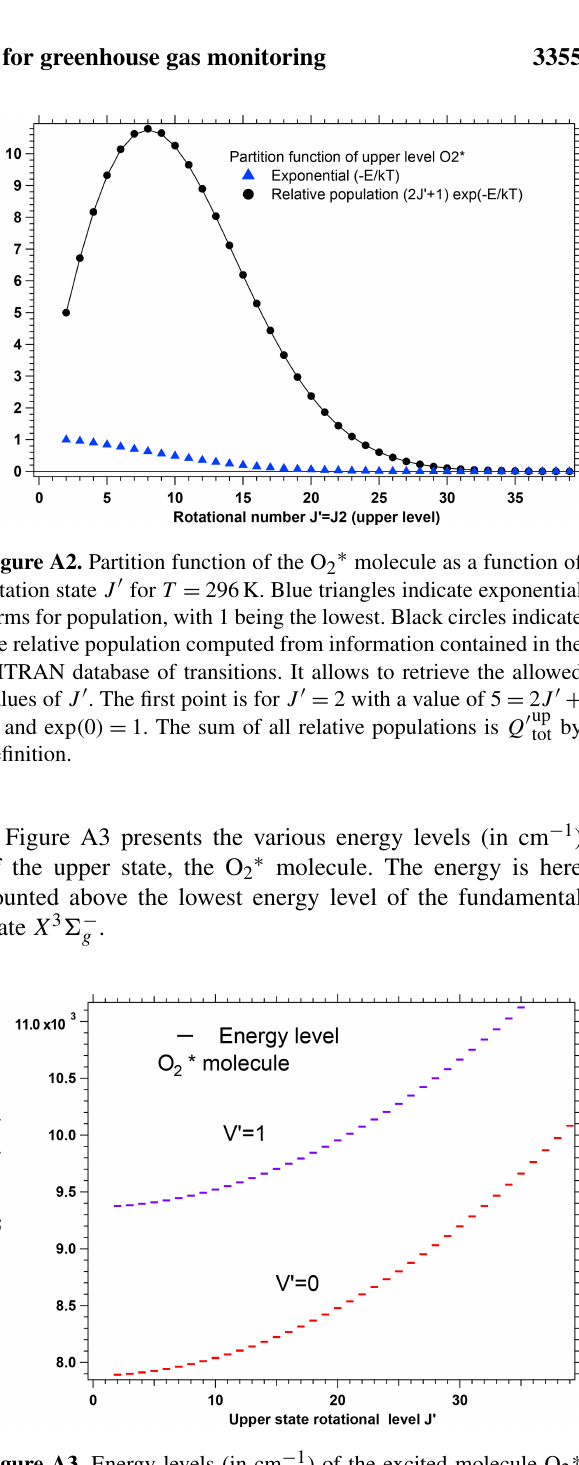
(cid:28) Q lo ≈ tot tot (cid:48) up tot (T) is Q tot (T)